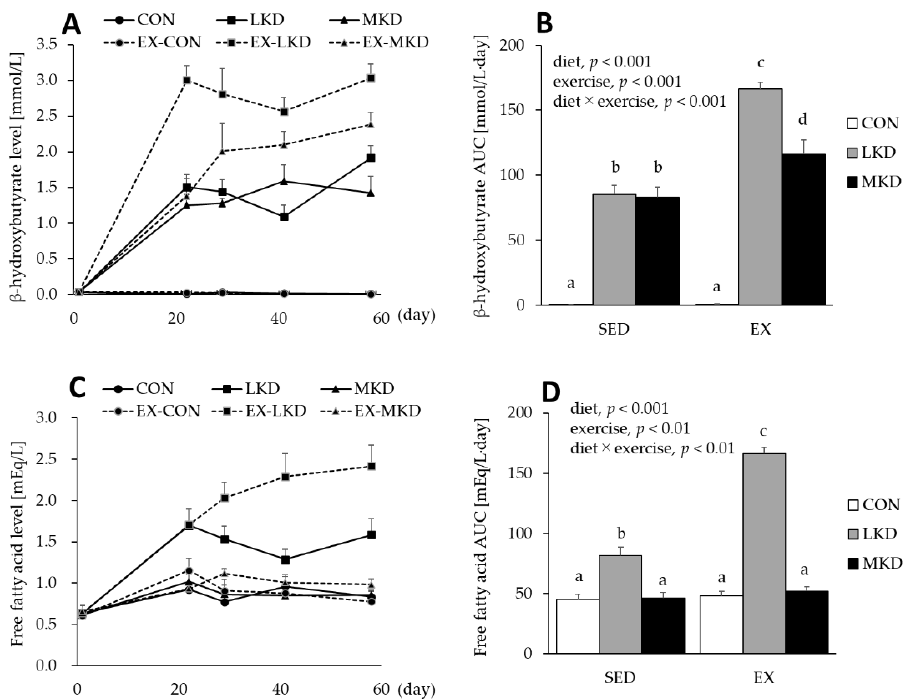
Figure 1. ( A ) Plasma β-hydroxybutyrate and ( C ) free fatty acid concentrations. The area under the curve (AUC) values for plasma ( B ) βHB and ( D ) FFA during the 8-week intervention were calculated in accordance with the trapezoidal rule. Two-way ANOVA was performed, followed by Tukey–Kramer multiple-comparison tests. Means labeled with the same letter are not significantly different from each other. Values are means ± SEM, n = 7.